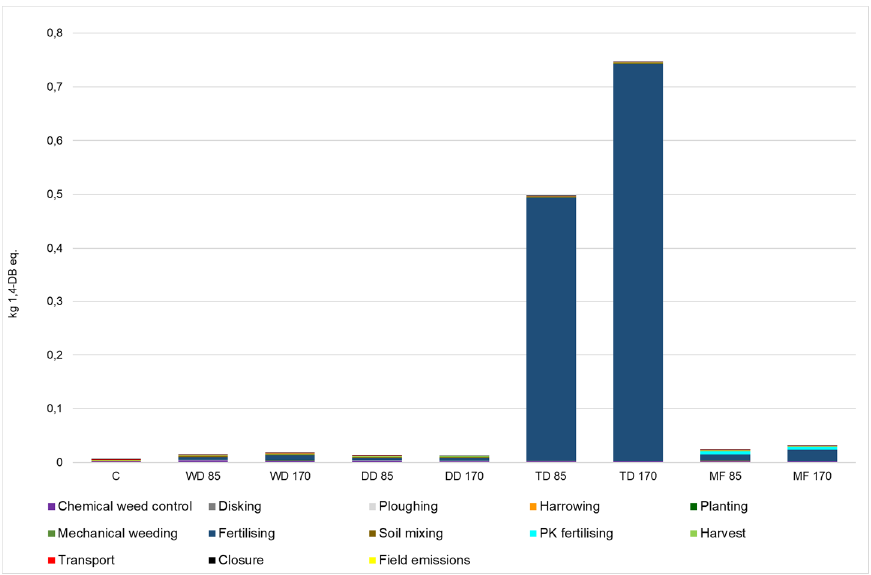
ff erent fertilisation